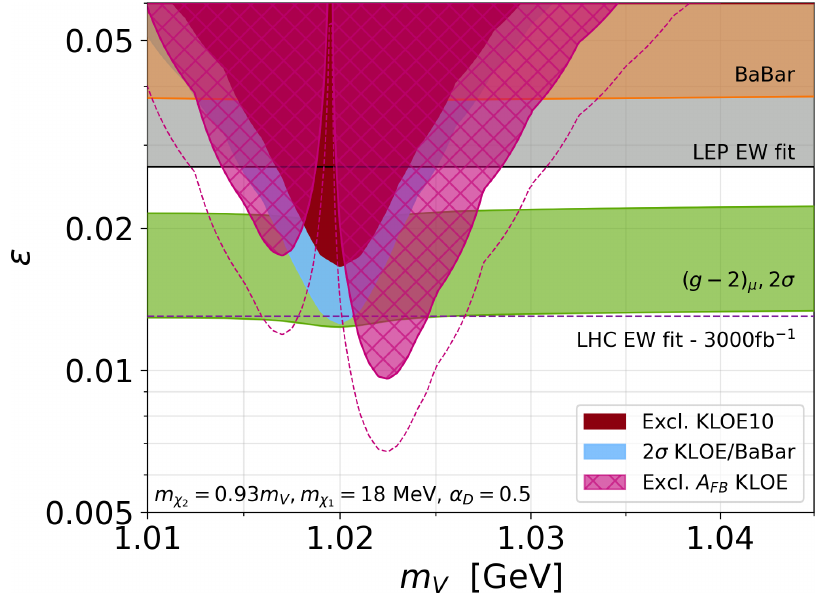
Figure 5 . Parameter range compatible at 2 σ with the experimental measurement of ∆ a µ (green region) resulting from a redetermination of the KLOE luminosity, for α = 0 . 5 , m = 0 . 93 m D χ 2 V and m = 18 MeV. In the blue region the KLOE and BaBar results for σ are brought into χ 1 had agreement at 2 σ . The red region corresponds to a shift of the KLOE measurement in tension with BaBar (and with the other experiments) at more than 2 σ . The limit from the electroweak fit at LEP (gray band), the projection for LHC run-3 [99] (violet dashed line), and the recasting of the BaBar limit [74] (orange band) are also shown (see text). The hatched magenta region corresponds to the conservative 2 σ exclusion from ∆ A , while the magenta dashed line corresponds to the more FB aggressive exclusion limit (see